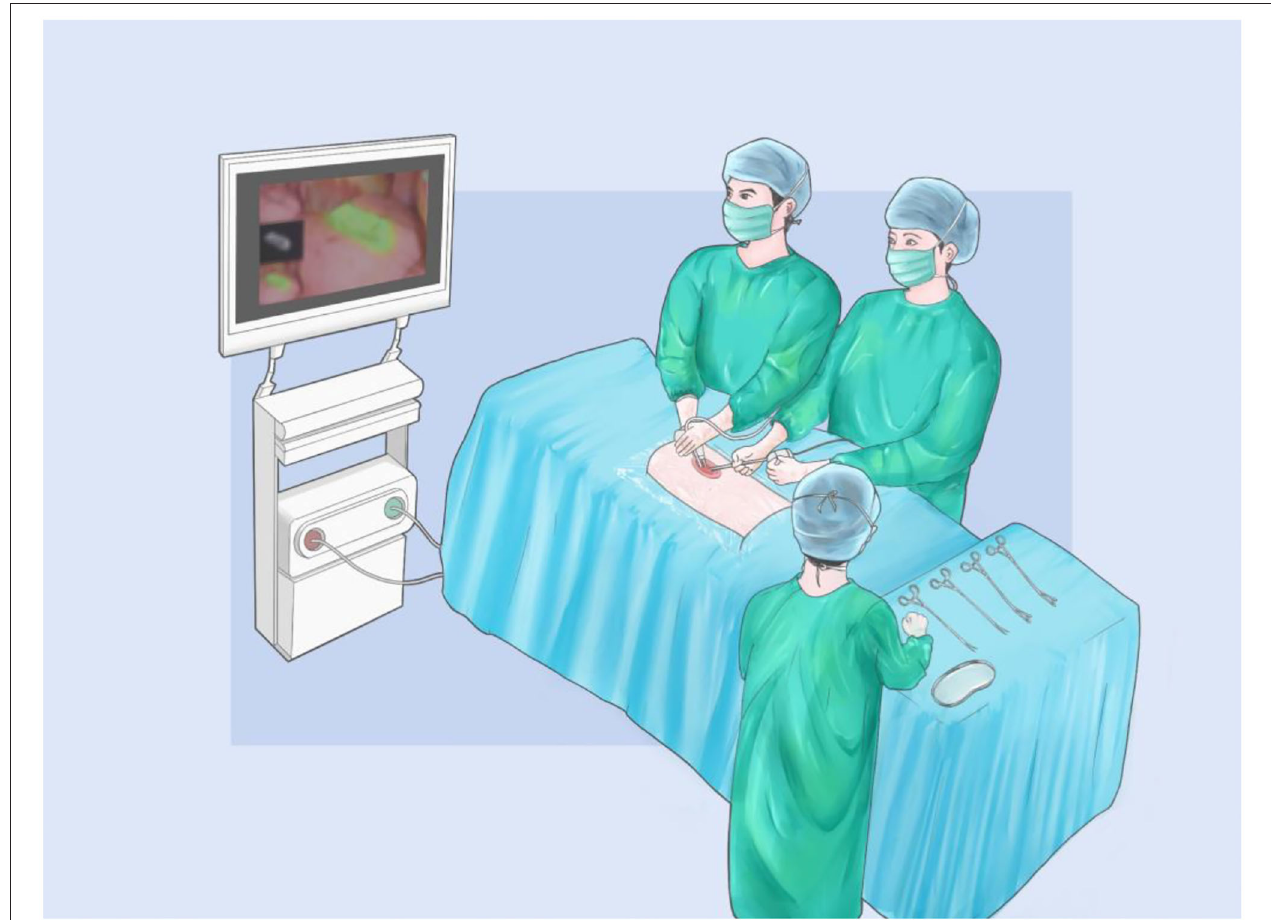
FIGURE 2 | The diagram of uniportal NIVATS in subxiphoid